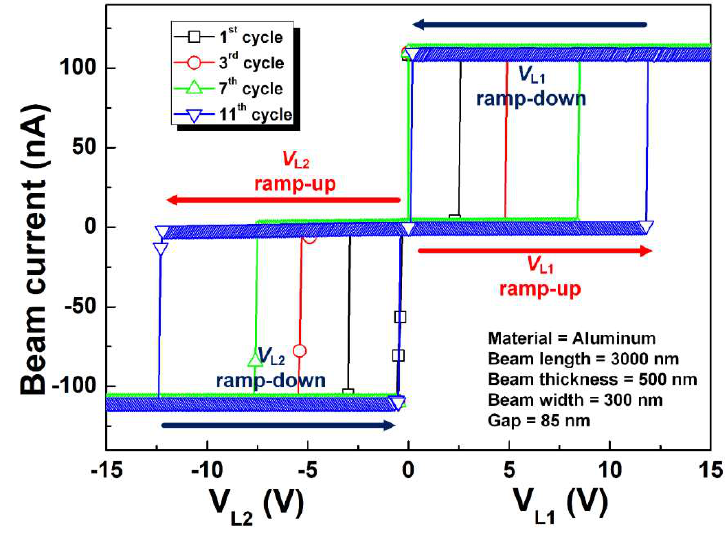
Figure 6. Current vs voltage curves of the fabricated nanoelectromechanical (NEM) memory switch encapsulated in a cavity.